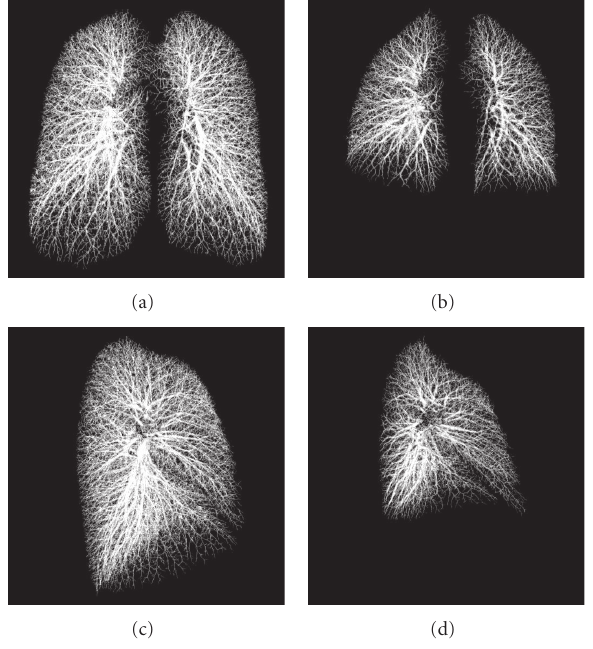
Figure 8: Two examples of segmentation results. (a) and (c) are the results from a TLC scan. (b) and (d) are from the associated FRC scan of the same subject. All images are shown at the same